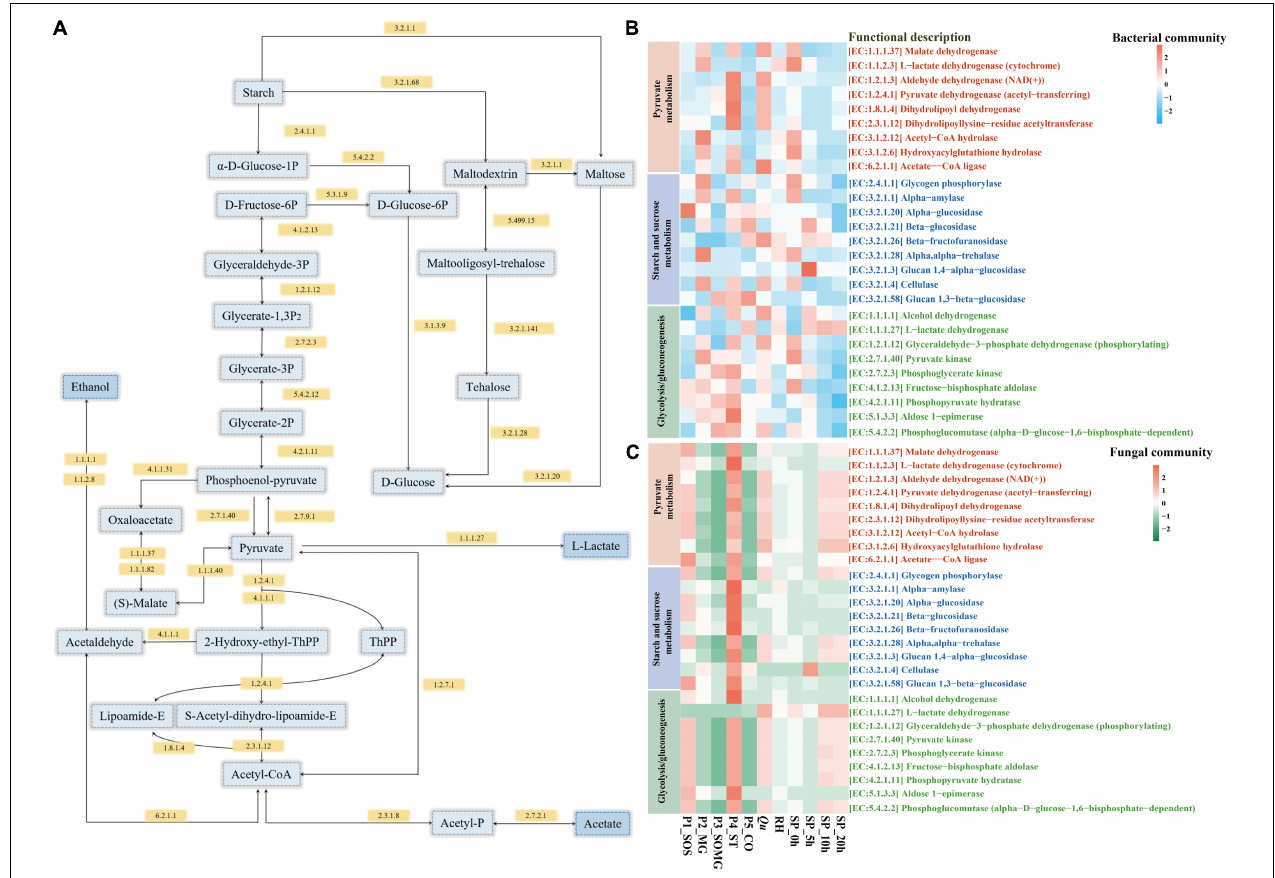
FIGURE 5 | Schematic overview of the metabolic processes involving pyruvate metabolism, starch and sucrose metabolism, and glycolysis/gluconeogenesis (A) . Heat map shows changes in the relative abundance of annotated functional enzymes related to saccharification and the formation of flavor compounds [ (B) bacterial community and (C) fungal